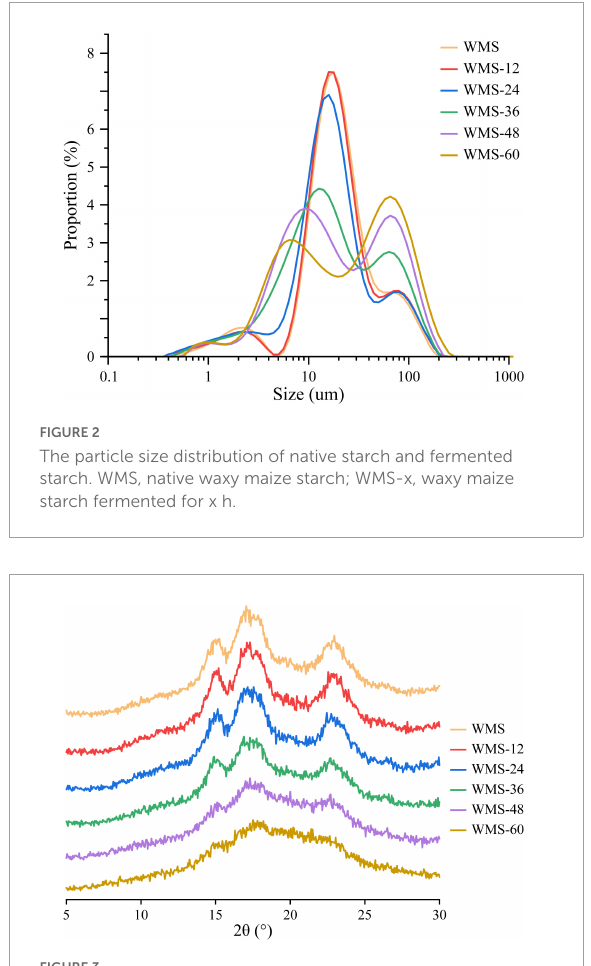
FIGURE3 X-ray diffraction spectra of native starch and fermented starch. WMS, native waxy maize starch; WMS-x, waxy maize starch fermented for x h.